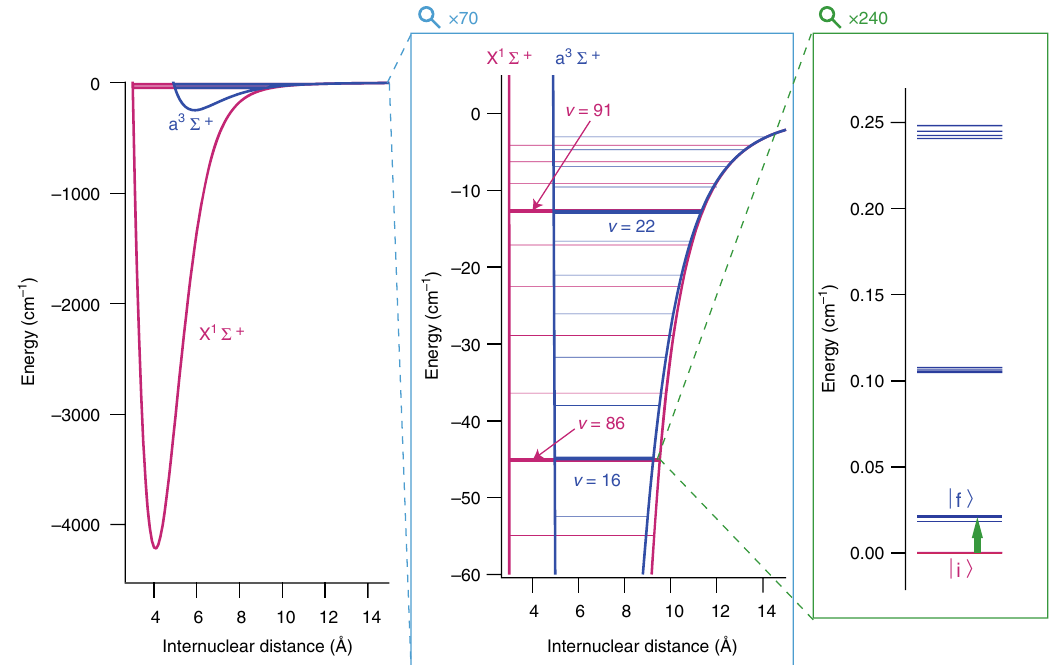
Fig. 1 Closely lying states of a 41 K 87 Rb molecule 15 . In the shallow range of the potentials, several pairs of closely lying vibrational states in X 1 Σ + and a 3 Σ + potentials are found. Among such pairs, we selected the combination of v = 86 state in X 1 Σ + and v = 16 state in a 3 Σ + . The large difference of potential depth between X 1 Σ + and a 3 Σ + leads to the large sensitivity W ≡ ∂ ν / ∂ (ln μ ) ≈ − 9.5 THz, whereas the transition frequency itself ( ≡ ν ) is in the microwave range ( ≈ 635 MHz). This yields a large sensitivity coef fi cient | K μ | ≡ | W / ν | ≈